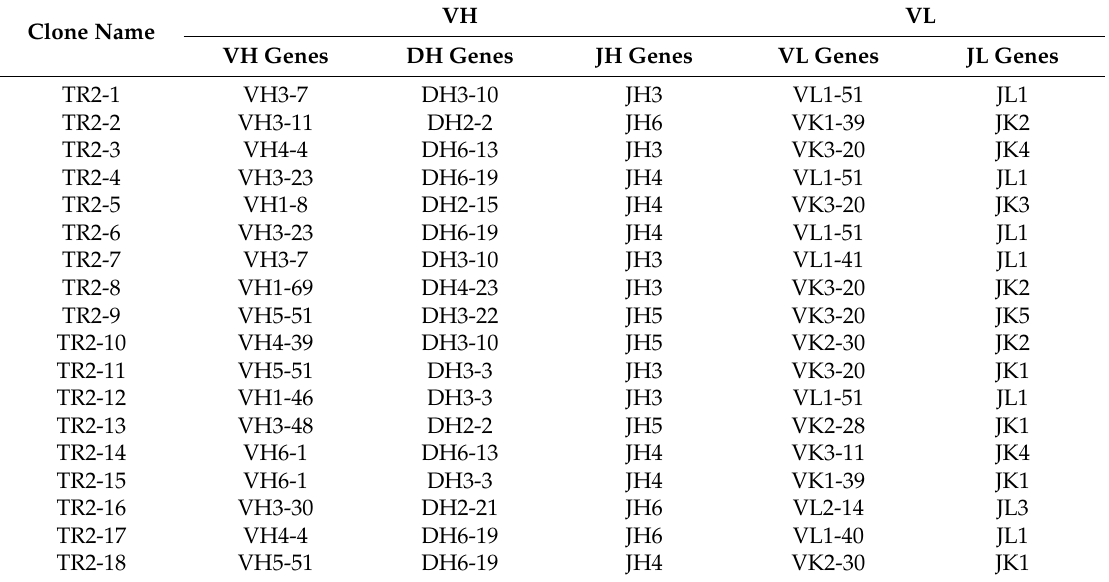
Table 1. The V-gene segment usage of the isolated human scFv against sDR5 from the human scFv